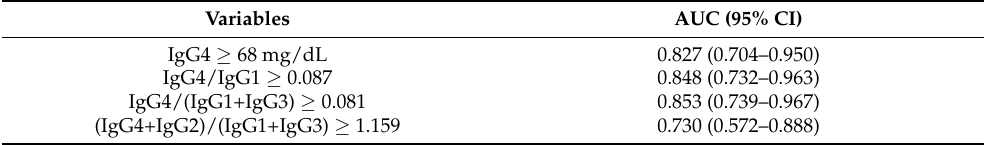
Figure 1. ROC curves of the IgG subclass combinations: ( A ) ROC curves of the IgG sub- class combinations for diagnosis of IgG4-SC from PSC. The ROC curve of IgG4 ≥ 68 mg/dL, IgG4/IgG1 ≥ 0.087, IgG4/(IgG1+IgG3) ≥ 0.081, and (IgG4+IgG2)/(IgG1+IgG3) ≥ 1.159 for com- parison. ( B ) ROC curves of the IgG subclass combinations for the diagnosis of IgG4-SC from CCA. The ROC curve of IgG4 ≥ 52 mg/dL, IgG4/IgG1 ≥ 0.087, IgG4/(IgG1+IgG3) ≥ 0.081, and (IgG4+IgG2)/(IgG1+IgG3) ≥ 1.159 for comparison. IgG, immunoglobulin G. Table 4. Area under the curve of serum IgG subclass combination for the differentiation of IgG4-SC from